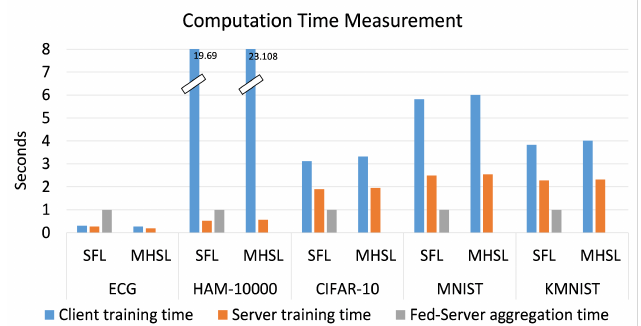
Figure 2. Computation time (in seconds) for SFL and